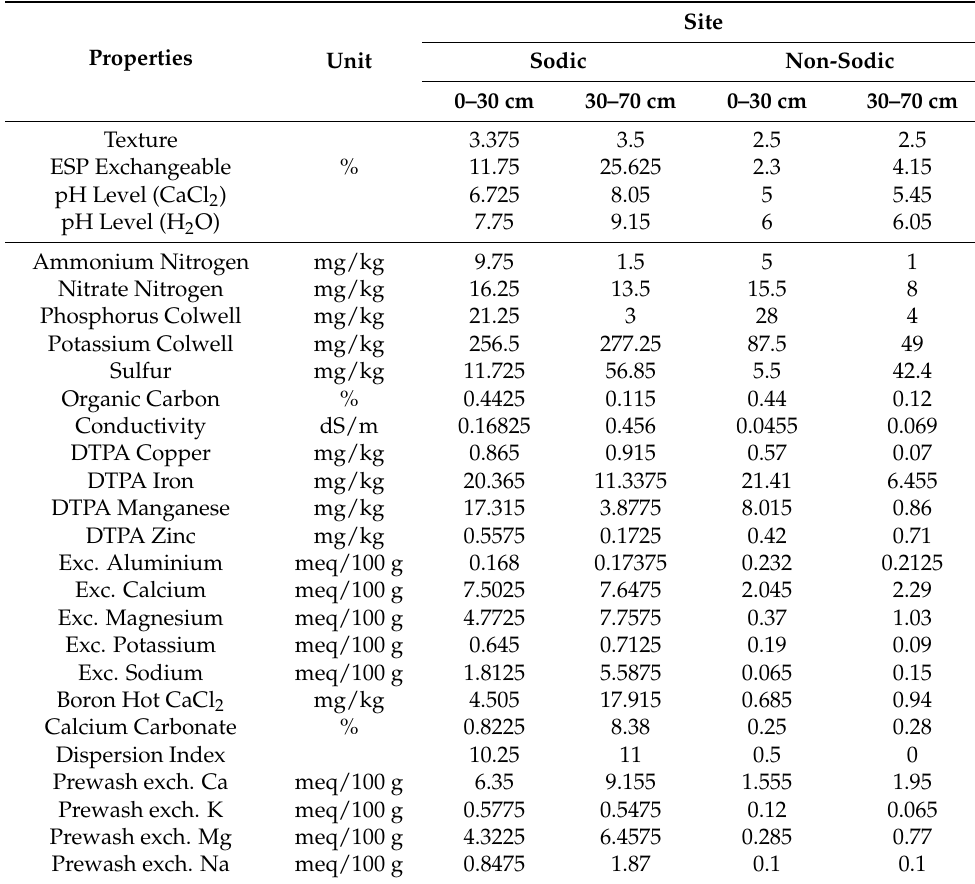
Table 1. Soil properties at different layers of the sodic and non-sodic site used to characterize wheat